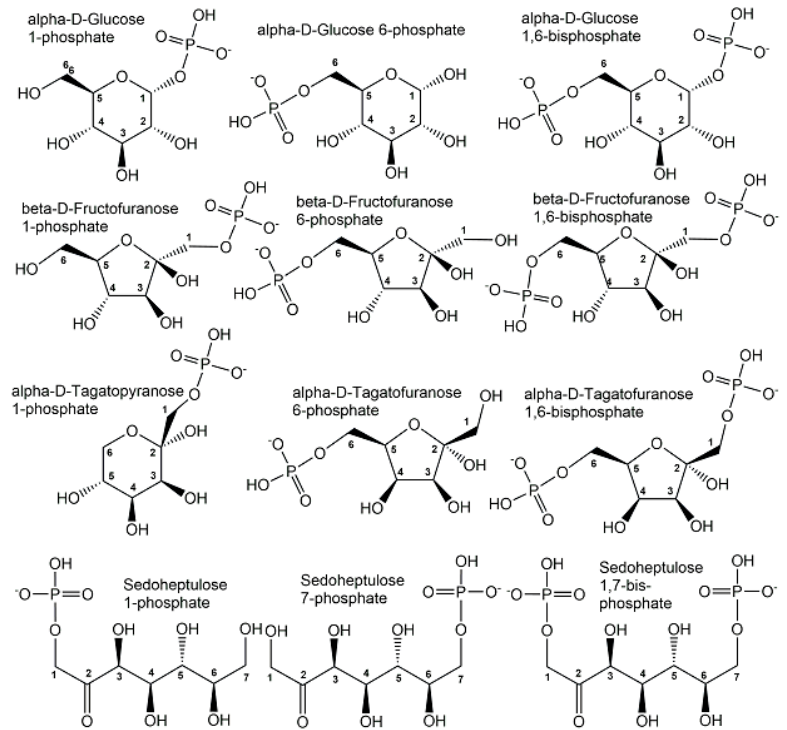
Figure 5. Selected endogenous mono- and bis-phosphorylated monosaccharide structures, with their phosphorylation sites designated by the corresponding carbon atom